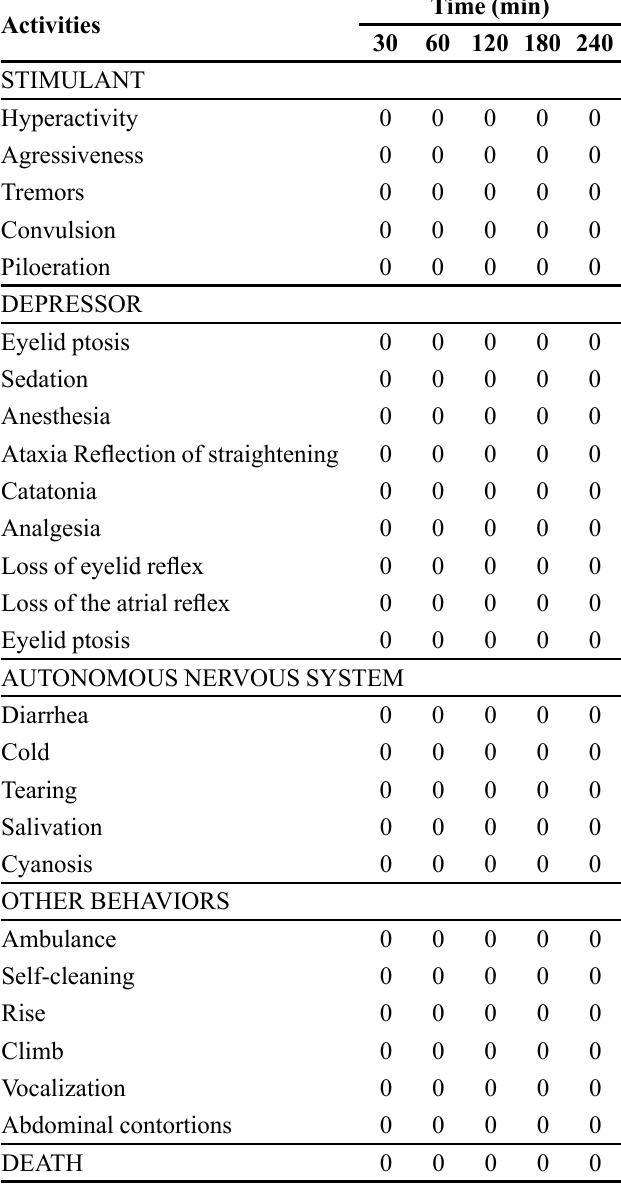
TABLE I - Acute toxicity of EEtOH-Zr/leaves at the oral dose of 2,000 mg/kg: (0) No effect; (-) diminished effect; (+)